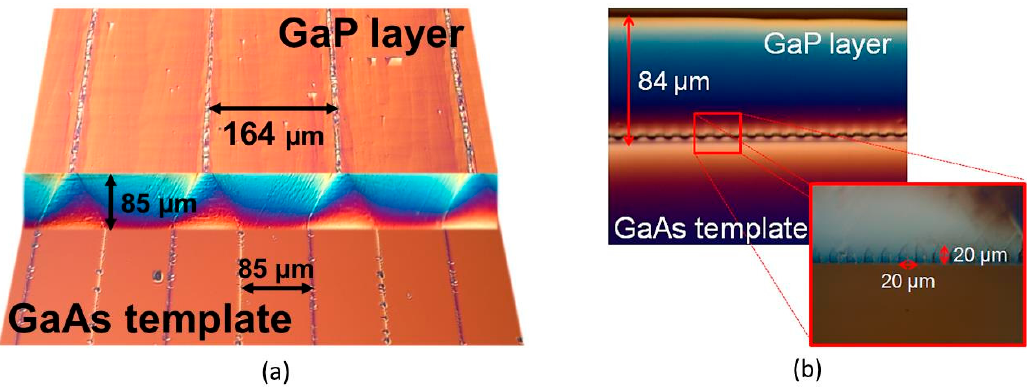
Figure 24. First attempts on HVPE heteroepitaxy of OPGaP on OPGaAs templates at: ( a ) larger and ( b ) finer domain width. The left image is a 3D reconstruction showing the top surfaces of the layer before and after the growth and its cross section. The right image is a cross section of another layer grown at the same conditions on a pattern with finer periodicity [57]. (Reproduced from [57] with the permission of EOS).